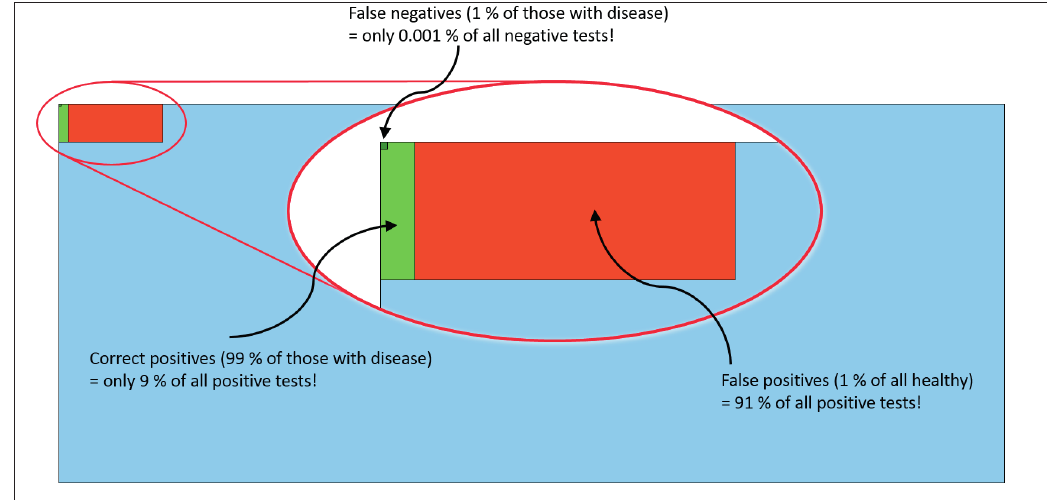
Fig. 1. Visualization of the rate of false positives when both sensitivity and specificity are extremely high. This is the best case scenario – real life performance of diagnostic or statistical tests will be much worse. (Specificity of a diagnostic test corresponds to [1 - type I error] of a hypothesis test and sen- sitivity corresponds to [1 - type II error]). Ignoring the prior probability leads to misleading conclusions. Key: Blue = true negatives, red = false positives, light green = true positives, dark green = false negatives.